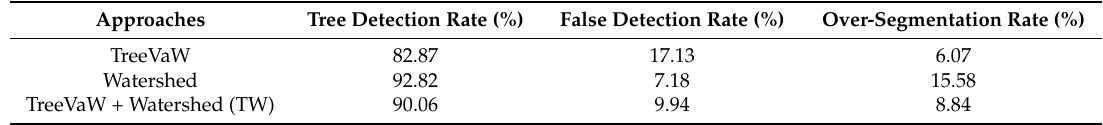
Table 4. Results of different tree segmentation